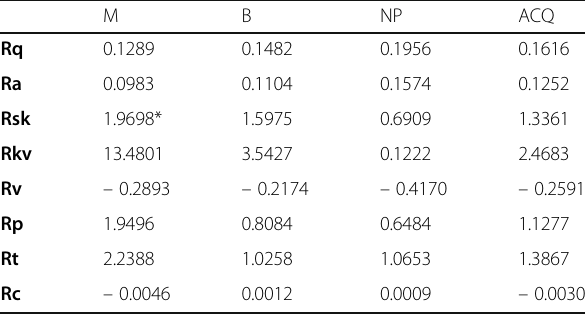
Table 2 Roughness parameters analyzed by SurfCharJ